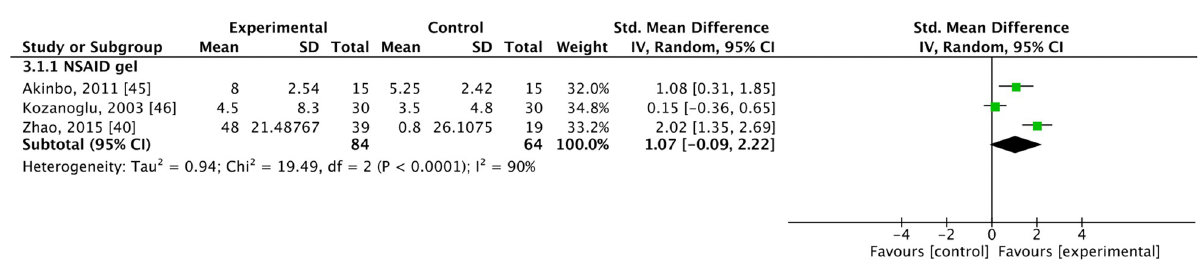
Figure 5. Forest plot for changes from baseline based on range of motion. SD, standard deviation; CI, confidence interval.